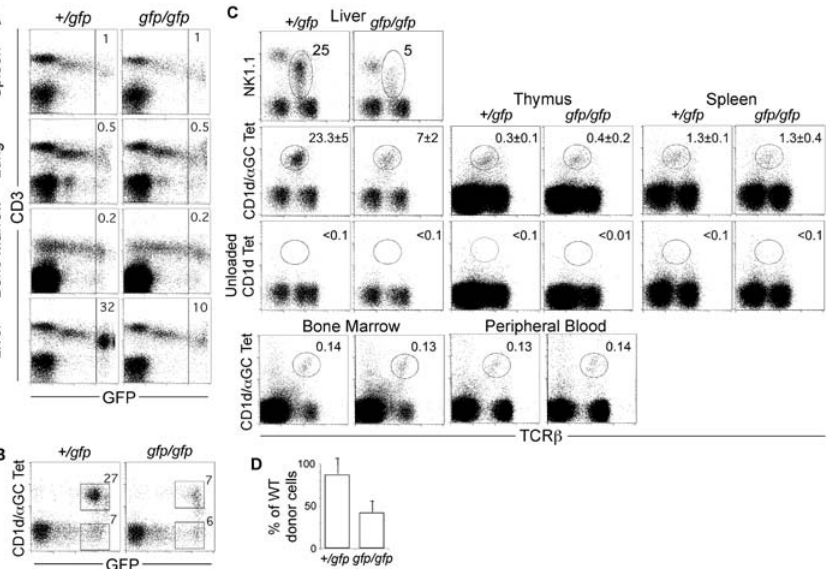
Figure 4. CD1d-Reactive NKT Cells Express CXCR6, Are Enriched in Liver, and Are Selectively Reduced in CXCR6-Deficient Mice Splenocytes, thymocytes, and lung, bone marrow, blood, and liver leukocytes from cxcr6 gfp/ þ ( þ / (cid:1) ) and cxcr6 gfp/gfp ( (cid:1) / (cid:1) ) mice were stained with one of the following combinations: K1.1 PE-conjugated antibodies and APC-conjugated anti-TCR b ; PE-conjugated CD1d tetramer loaded with a - GalCer ( a GC) and APC-conjugated anti-TCR b ; or control unloaded tetramer and APC-conjugated anti-TCR b . (A) Expression of CD3 and GFP by cells from different